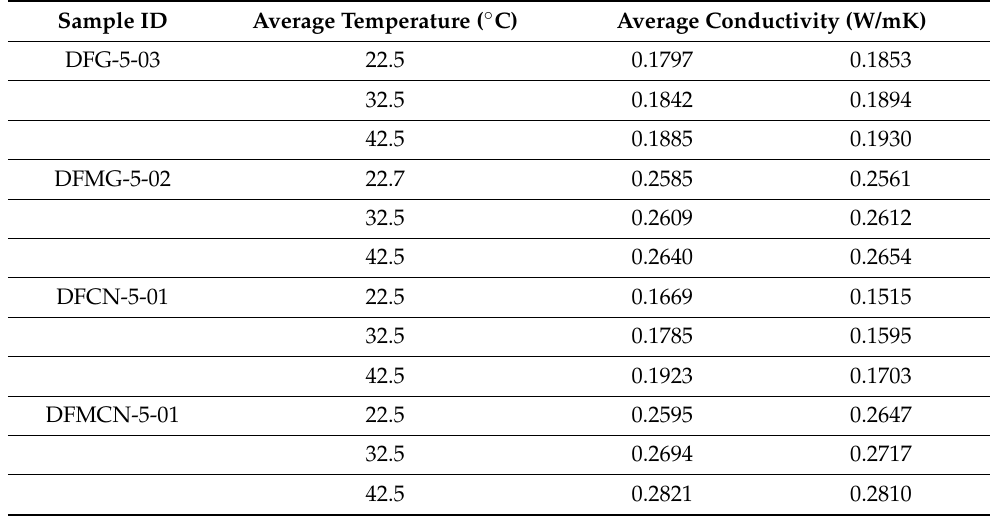
Table 4. Thermal conductivity of the prepared MWCNT/GNF-PVDF nanocomposite samples. Sample